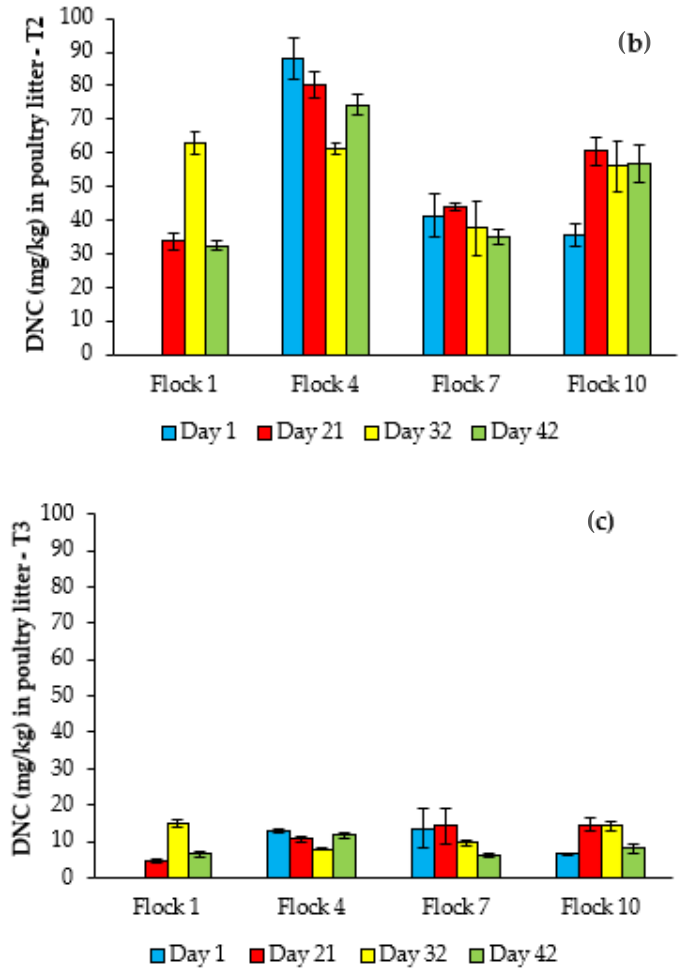
Figure 3. DNC concentration in poultry litter used for rearing multiple flocks of NCZ-fed broilers at 1, 21, 32 and 42 days of age in Treatment 1 (T1) ( a ), Treatment 2 (T) ( b ), and Treatment 3 (T3) ( c ). T1: NCZ at 125 mg/kg fed from 1 to 21 d; T2: NCZ at 125 mg/kg fed from 1 to 32 d; T3: NCZ at 40 mg/kg plus maduramicin at 3.75 mg/kg fed from 1 to 32 d; NCZ-free feed (withdrawal period): 22 to 42 d for T1; and 33 to 42 d for T2 and T3.